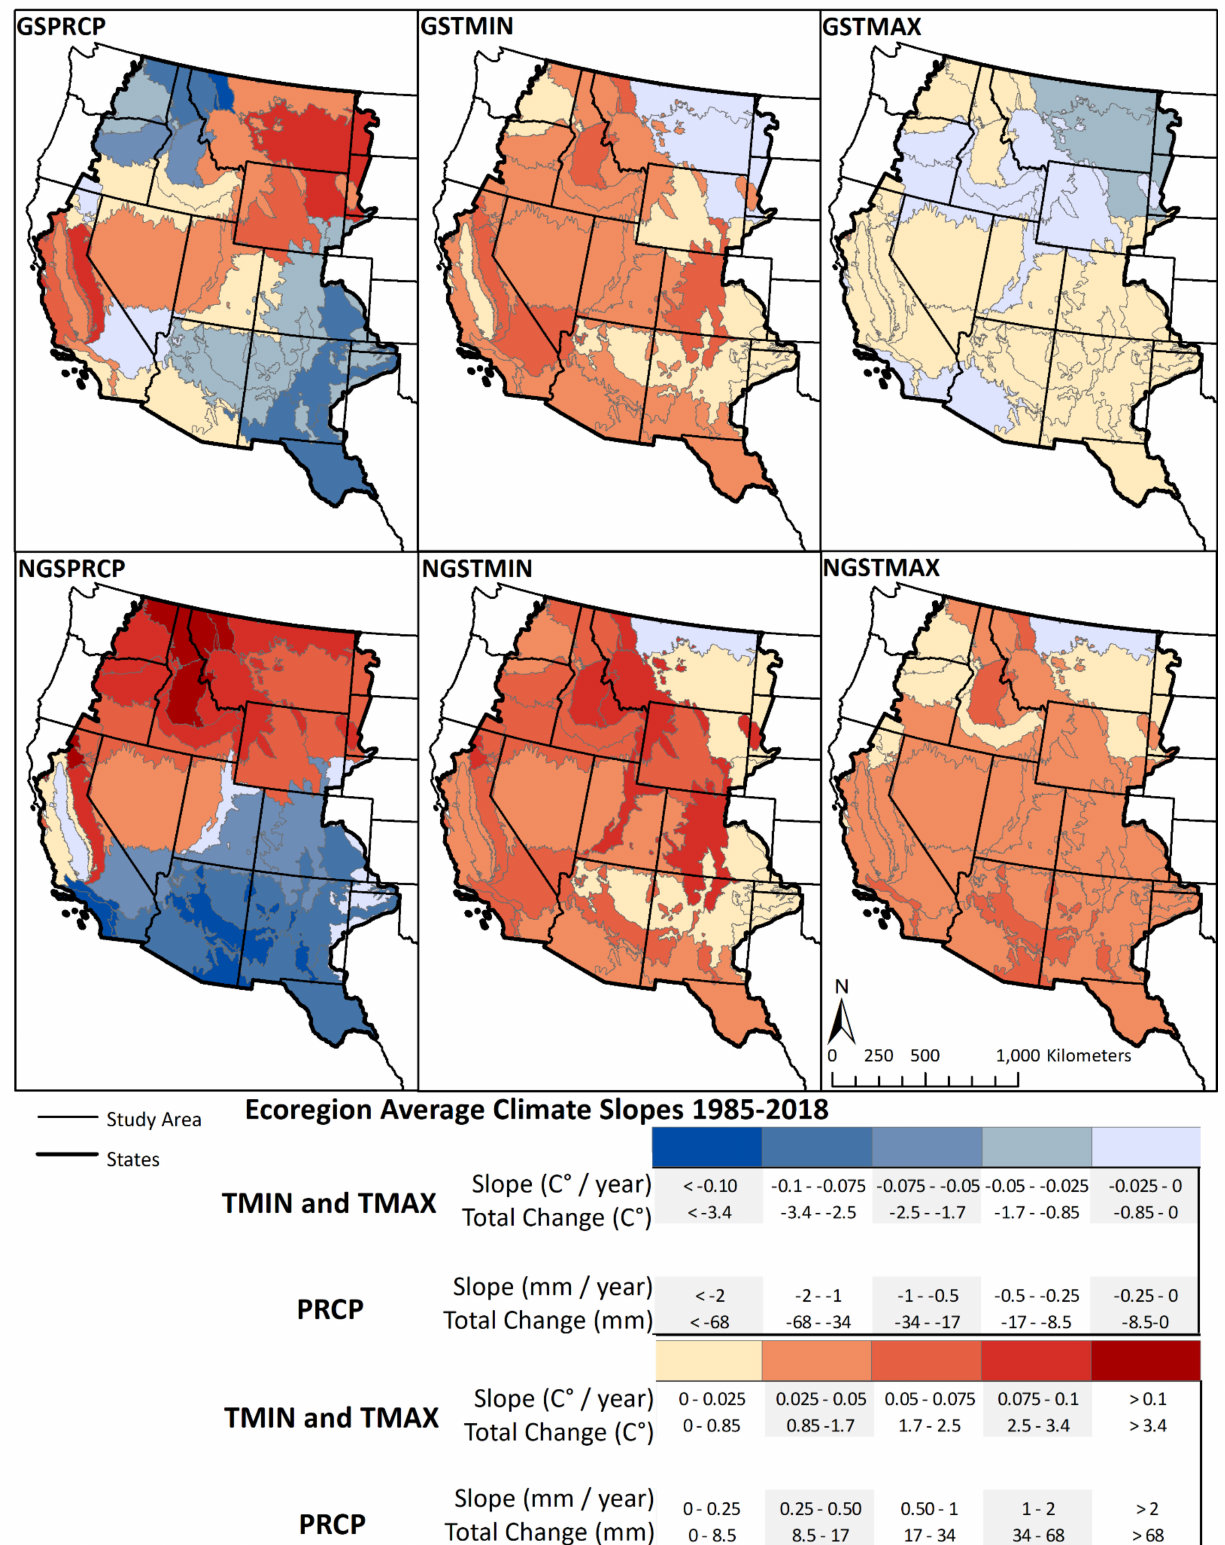
Figure 6. Growing season (April–September) and non-growing season (October–March) climate variable trends from 1985 to 2018 in rangeland pixels averaged by Environmental Protection Agency Level III